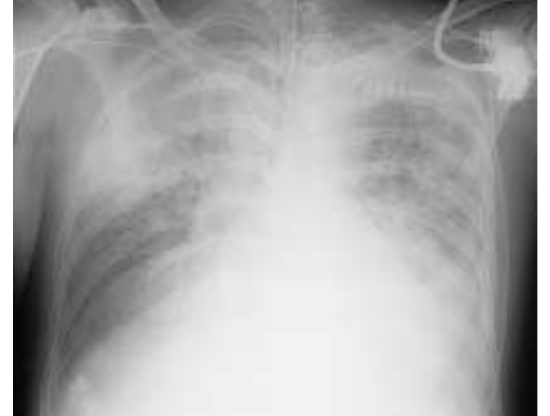
Chest radiograph showing extensive bilateral alveolar opacities.